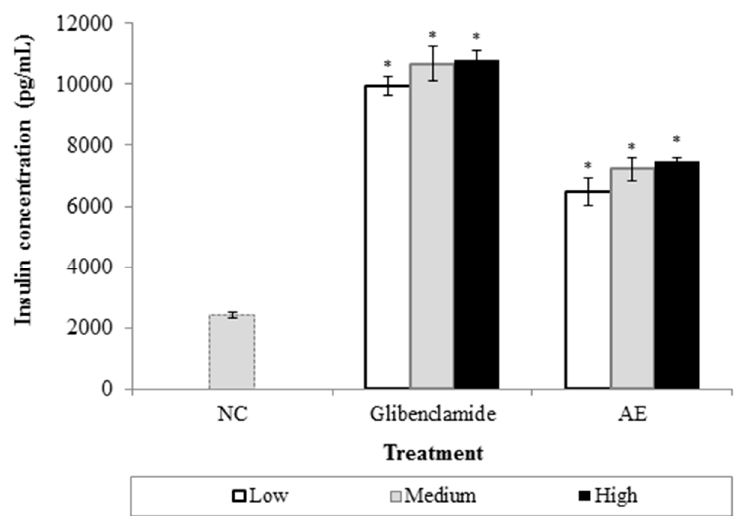
Figure 4. Effects of AE on insulin secretion by RIN-5F cells. Values are expressed as mean ± S.E.M ( n = 6). The concentrations of glibenclamide were determined as follows: low (0.988 µ g/mL); medium (9.88 µ g/mL), and; high (98.8 µ g/mL); whereas for AE, the range was as follows: low (6.25 µ g/mL); medium (12.5 µ g/mL), and; high (25 µ g/mL). * p < 0.05 is significant as compared to